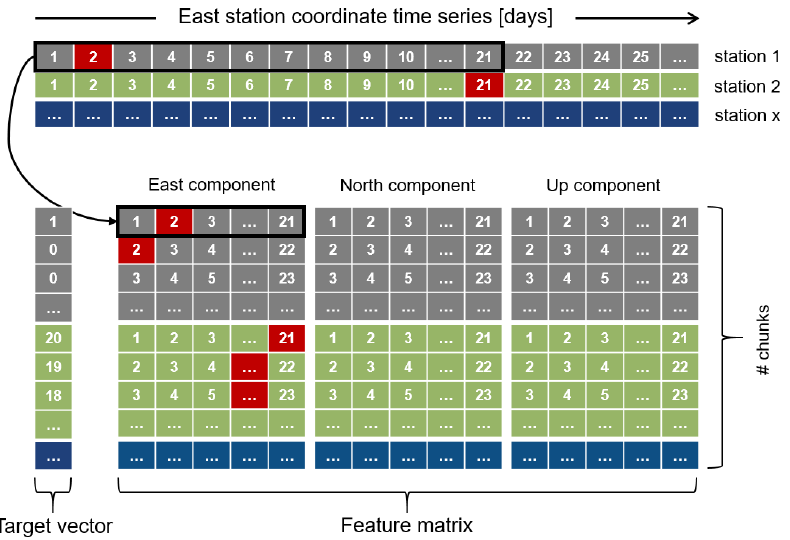
Figure 3. Example structure of target vector and feature matrix in case that all components are combined to one sample (respectively row) of the feature matrix for a chunk size m = 21 days. The target vector corresponds to the index where the discontinuity happens inside the chunk or 0 in case no discontinuity is present. Days with earthquakes causing discontinuities are highlighted in